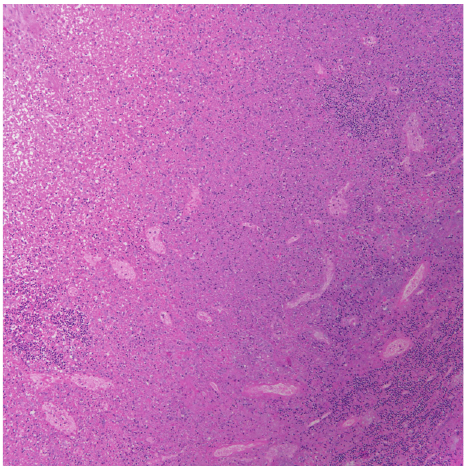
Figure 4: Necrotizing lymphadenitis of a lymph node with asso- ciated perinodal necrosis. Some mononuclear cells may represent macrophages phagocytosing nuclear debris (Hematoxylin-eosin stain, original magnification ×